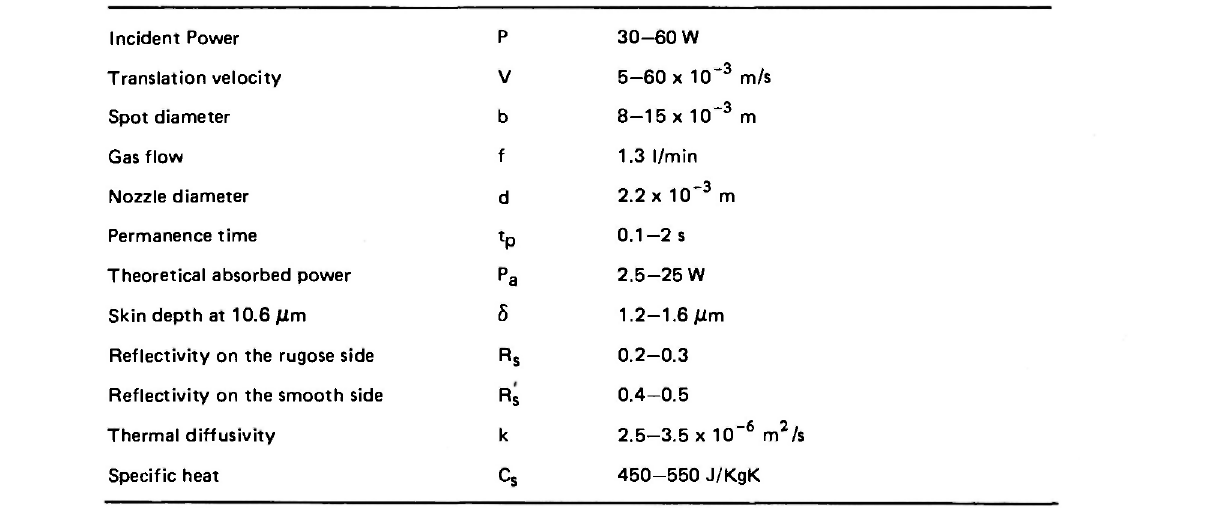
TABLE 2. Average Values of Laser Heat Treatment Parameters and Amorphous Metals' Thermal